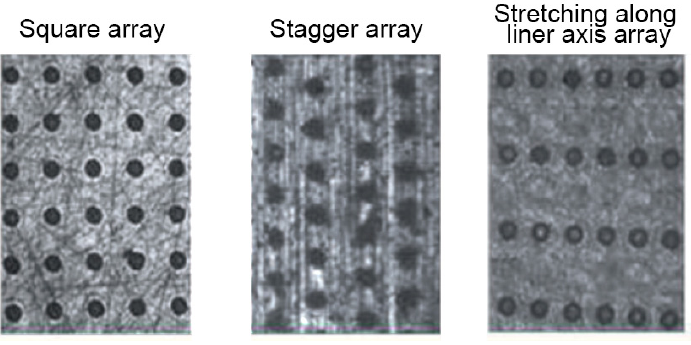
Figure 13. Dimple arrays used in [104].